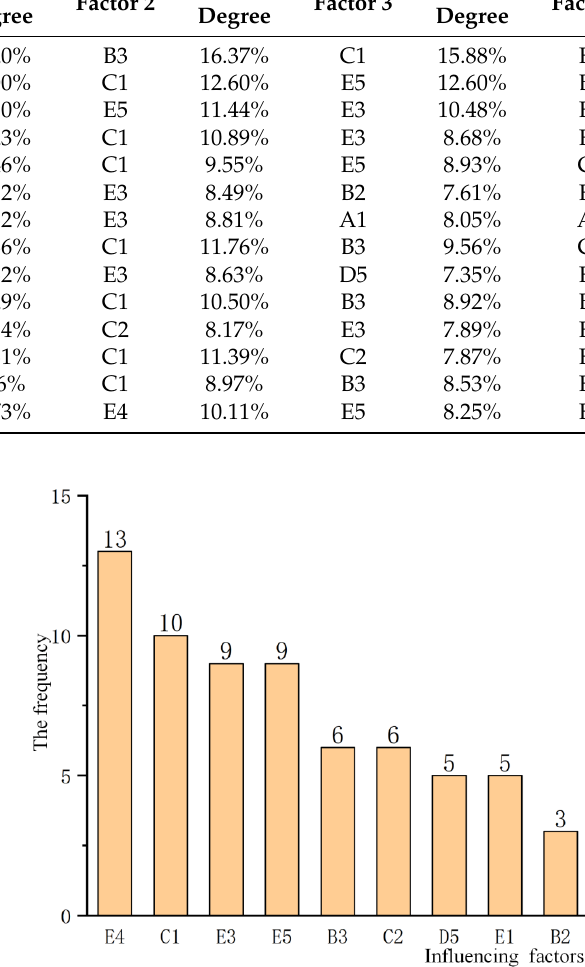
(personnel funding arrangement), E3 (irrigation water-saving capacity), E5 (embankment compliance capacity), B3 (professional water conservancy related proportion), and C2 (maintenance funding arrangement) were all indicators with a total frequency of more than 5 in the top five cities and prefectures. It can be seen from Table 6 and Figure 7 that urban and rural water supply capacity, irrigation water-saving capacity, and embankment compliance capacity are indicators of grassroots water conservancy service capacity. There is still room for the development of grassroots water conservancy service capacity in Hunan Province. Urban and rural water supply capacity is an important part of building a moderately prosperous society and a solution to overcoming poverty. Except for Xiangtan, the irrigation water-saving capacity of other cities and prefectures ranks among the top five obstacle degrees. It is urgent to accelerate the construction of urban and rural water supply integration and solve the